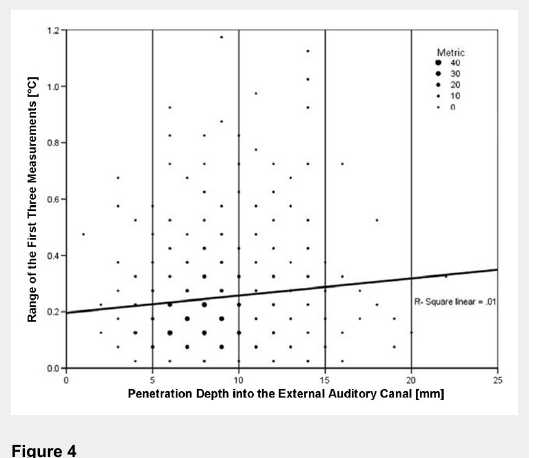
Correlation between penetration depth and range of infrared ear temperature measurement. Size of the dots represents number of measurements.